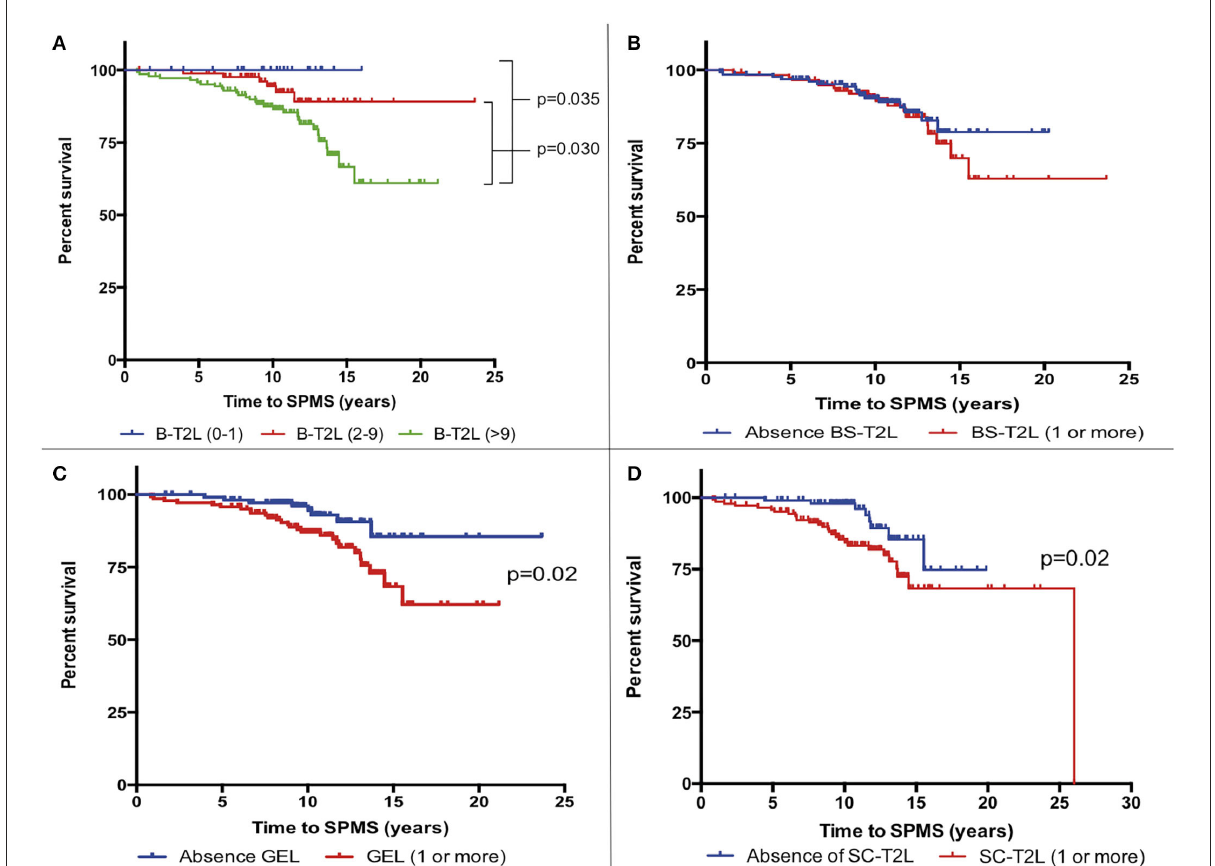
FIGURE3 Kaplan-Meier survival analysis of the time to reach a diagnosis of secondary progressive multiple sclerosis (SPMS) according to MRI characteristics. (A) Number of brain T2 lesions (B-T2L). (B) Presence vs. absence of infratentorial lesions (BS-T2L). (C) Presence or absence of brain gadolinium-enhancing lesions (GEL). (D) Presence or absence of cervical spinal cord T2 lesions